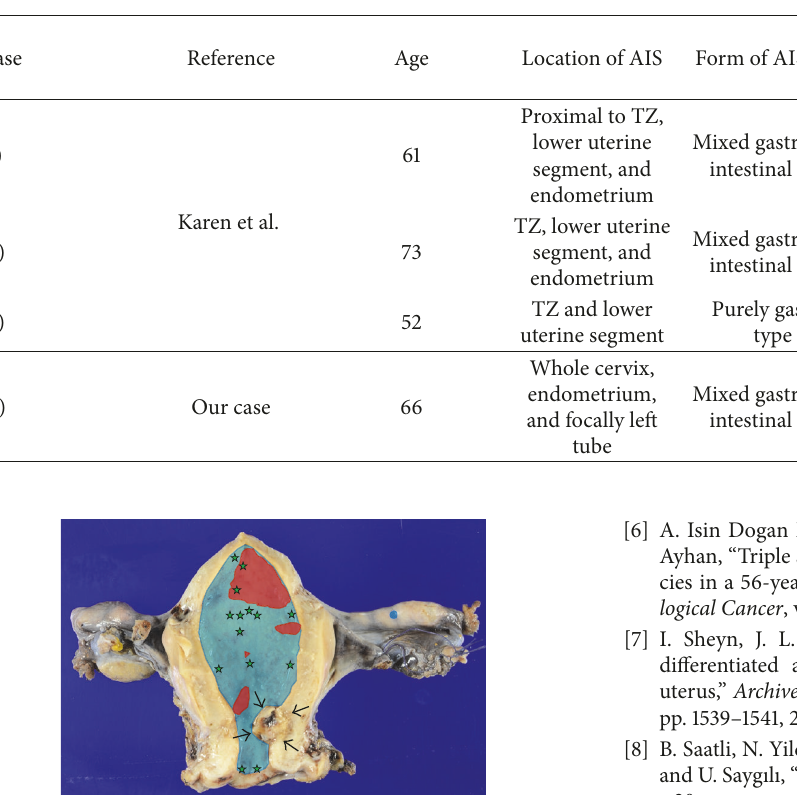
Table 4: Cases of gastric type AIS with intraepithelial spreading to the endometrium: a summarizing review of the references.